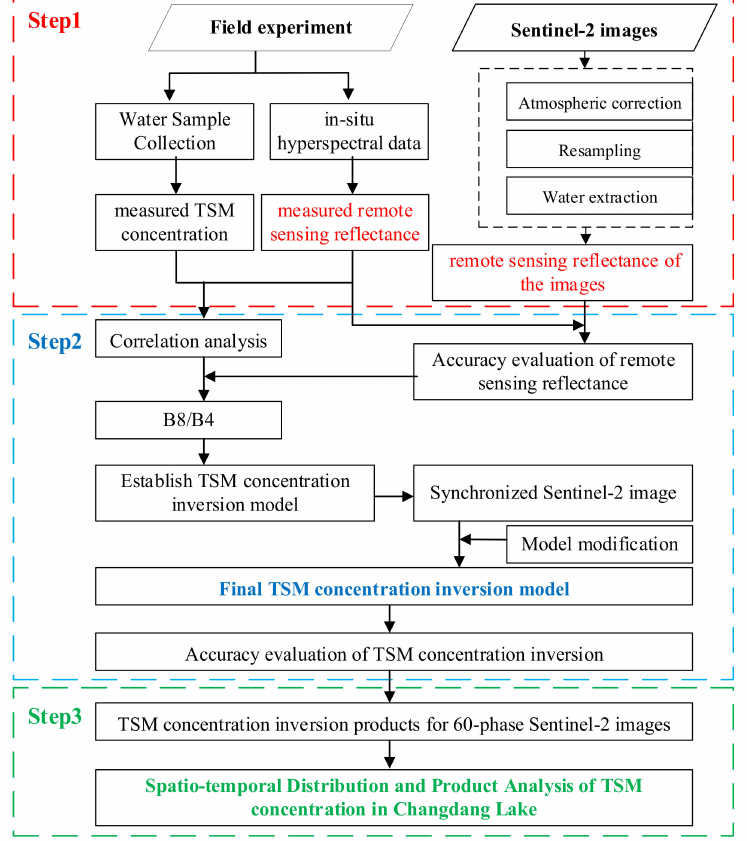
Figure 2. The technical flow chart of this